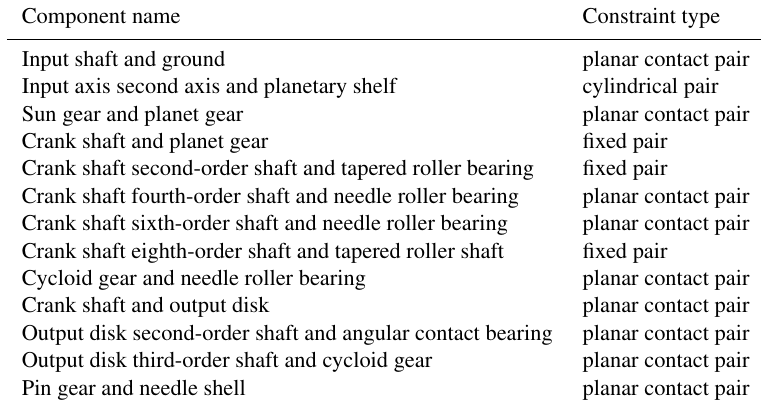
Table 6. Establishment of model constraint pairs.